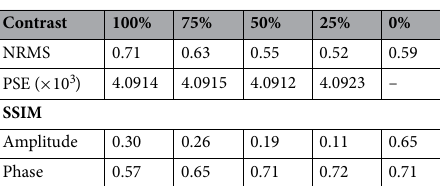
Table 2. Comparison of the SSIM and PSE indices of the reconstructed images in Fig. 5e,f respect to the scattering power of each simulated hologram.